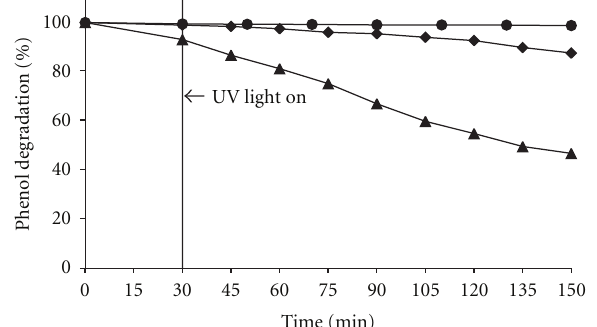
Figure 4: Photocatalytic degradation of phenol under di ff erent conditions. Conditions: catalyst comprised TiO 2 nanotubes, silica gel, and colloidal silica in the ratio of 3 :2: 20; catalyst loading = 1g/L, air flow rate = 0.3L/min, and initial phenol concentration = 30mg/L. ( • = in darkness, in the absence of the catalyst, darkness, in the presence of the catalyst, and the absence of the